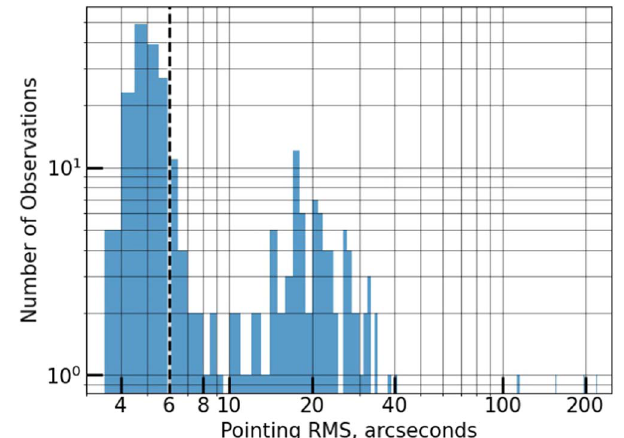
Figure 9. CUTE CCD dark frame background rates plotted against detector temperature and colored by the elevation of the Sun with respect to the telescope boresight. In general, higher CCD temperatures produce higher background count rates. Background rates are additionally in fl uenced by the position of astronomical bodies like the Sun as exempli fi ed here, as well as the moon and Earth. At the time of writing, we are still exploring sources of contribution to background rates.